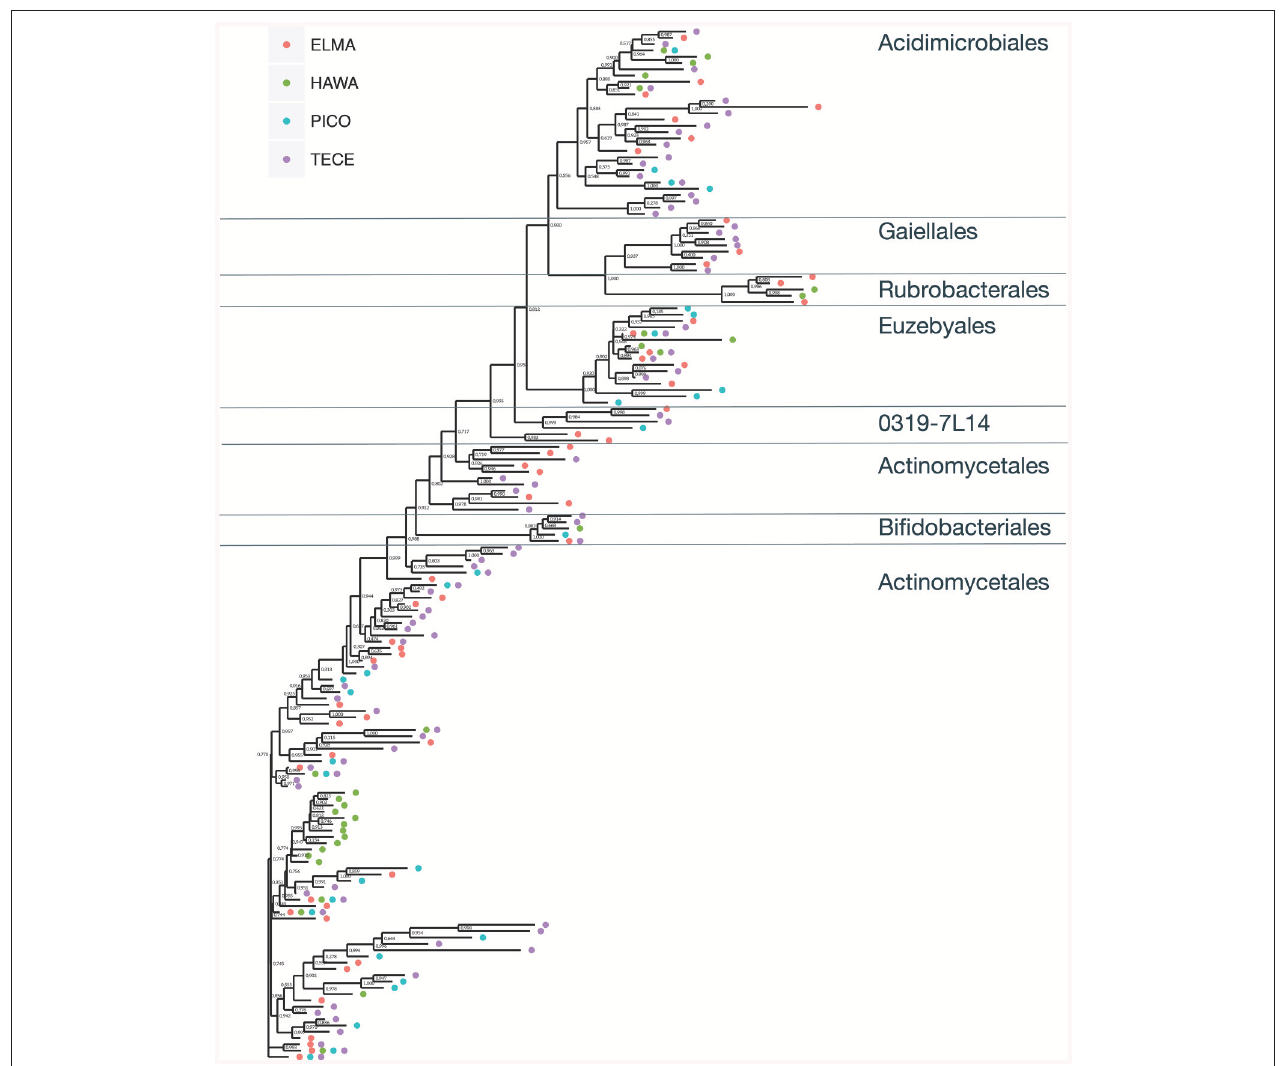
FIGURE 5 | Unrooted approximate maximum likelihood tree showing the relationship and occurrences of Actinobacteria OTUs across all four sample locations. Bootstrap values are